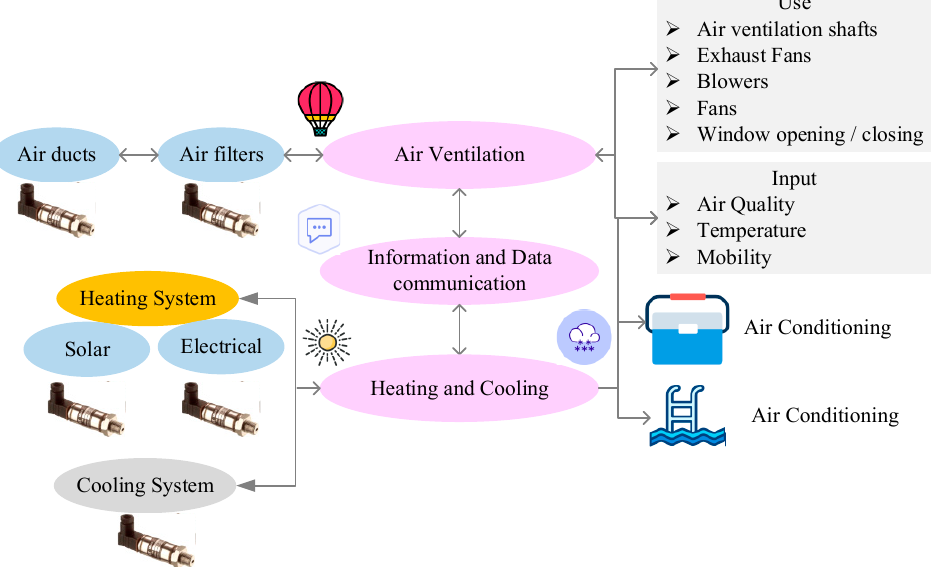
Figure 3. Architecture of heating, ventilation and cooling systems for intelligent green buildings (Source: the authors). (Source: the